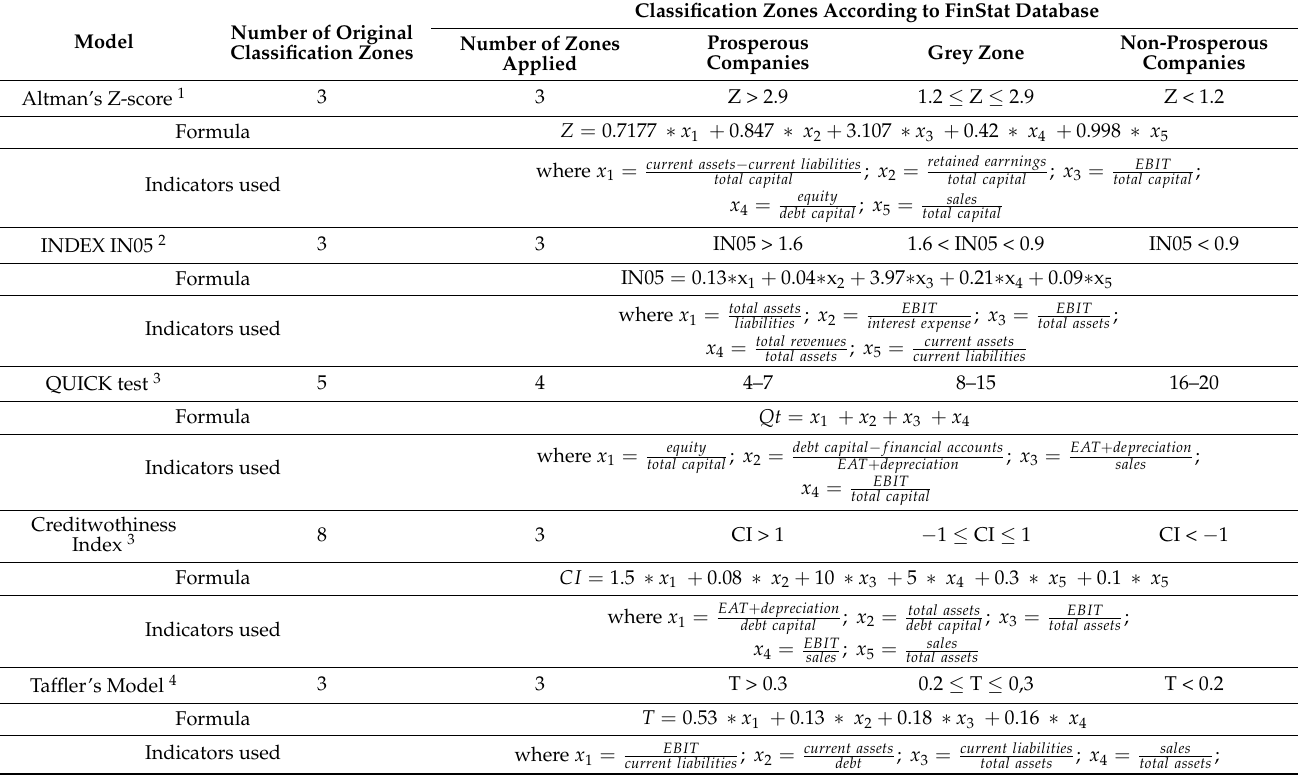
Table A2. Parameters of globally disseminated default prediction models.